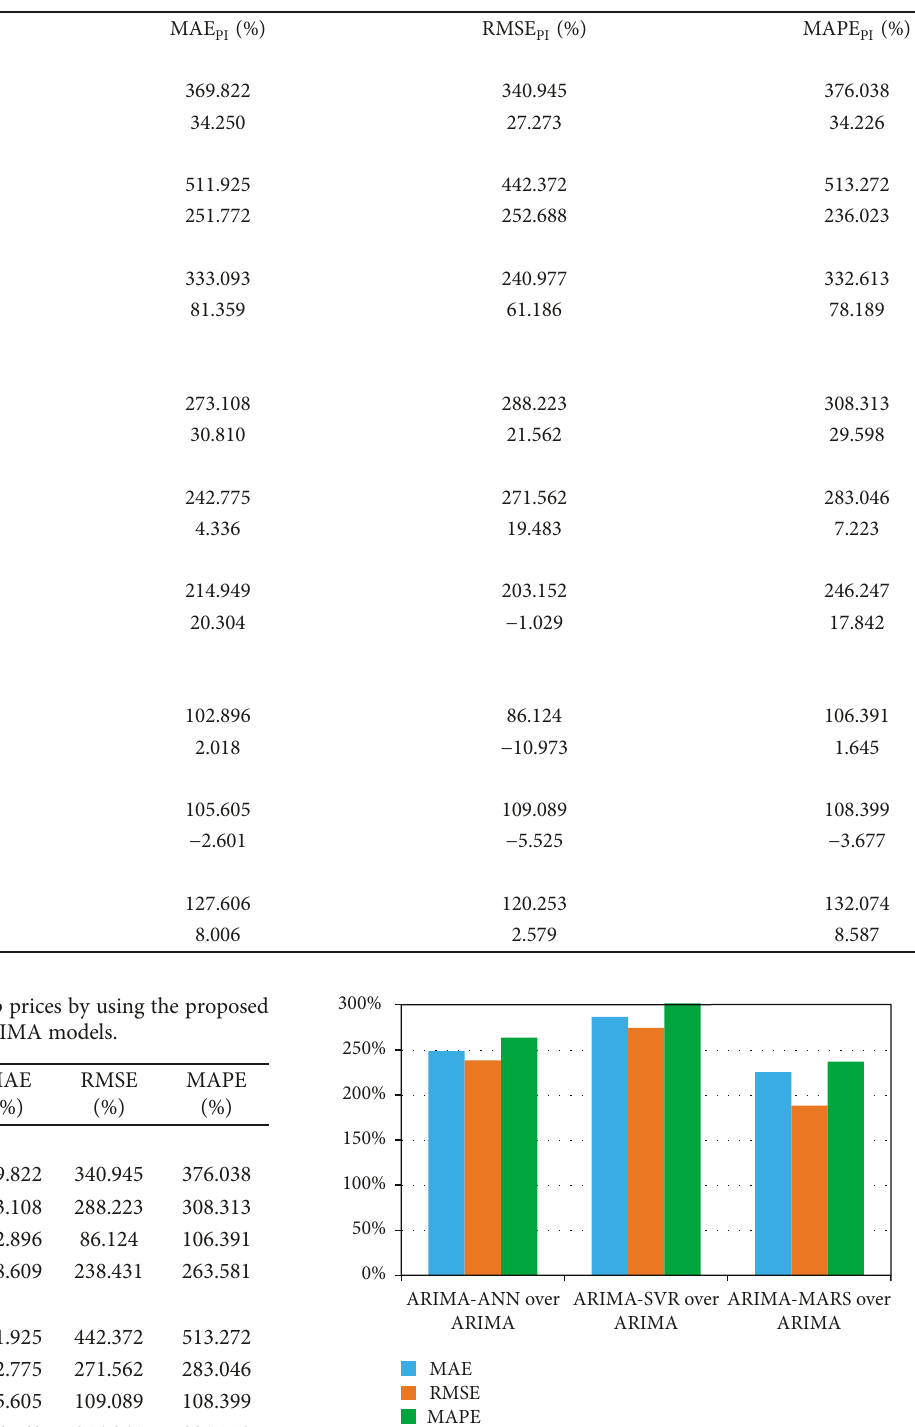
Table 19: Improvement of the proposed integrated models over single models.